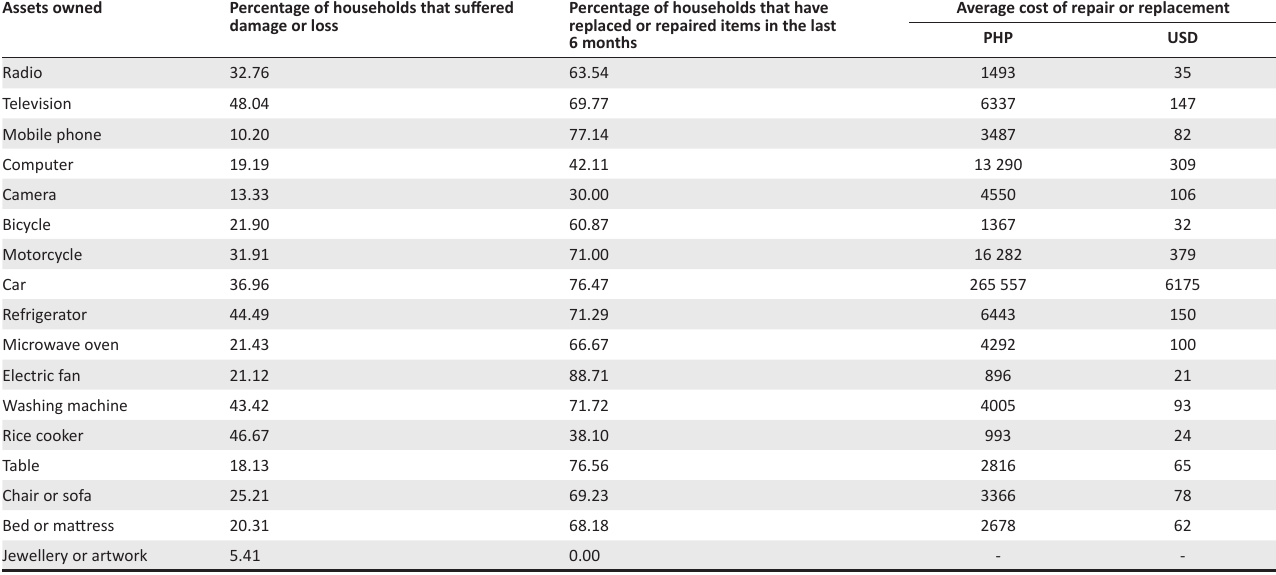
TABLE 6: Damage to assets. Assets owned